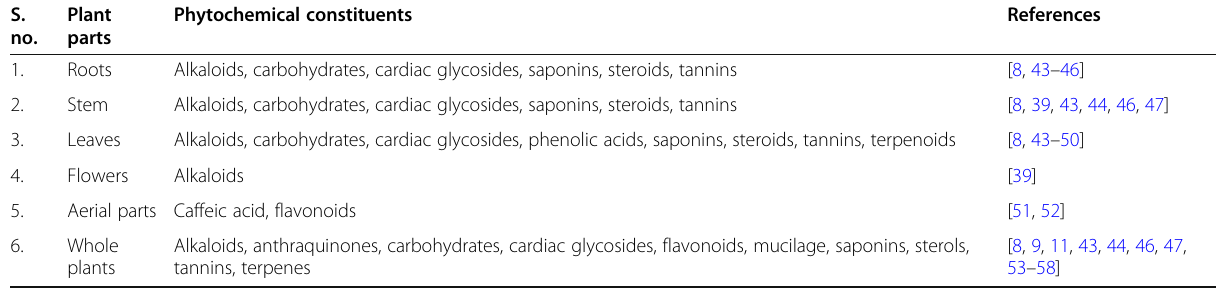
Table 1 Phytochemical constituent in different parts of W. Indica S. no.